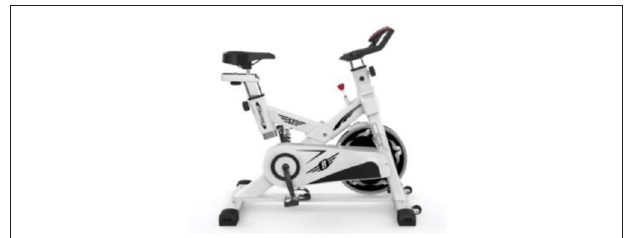
FIGURE 2 | Stationary bicycle used in the experiment.